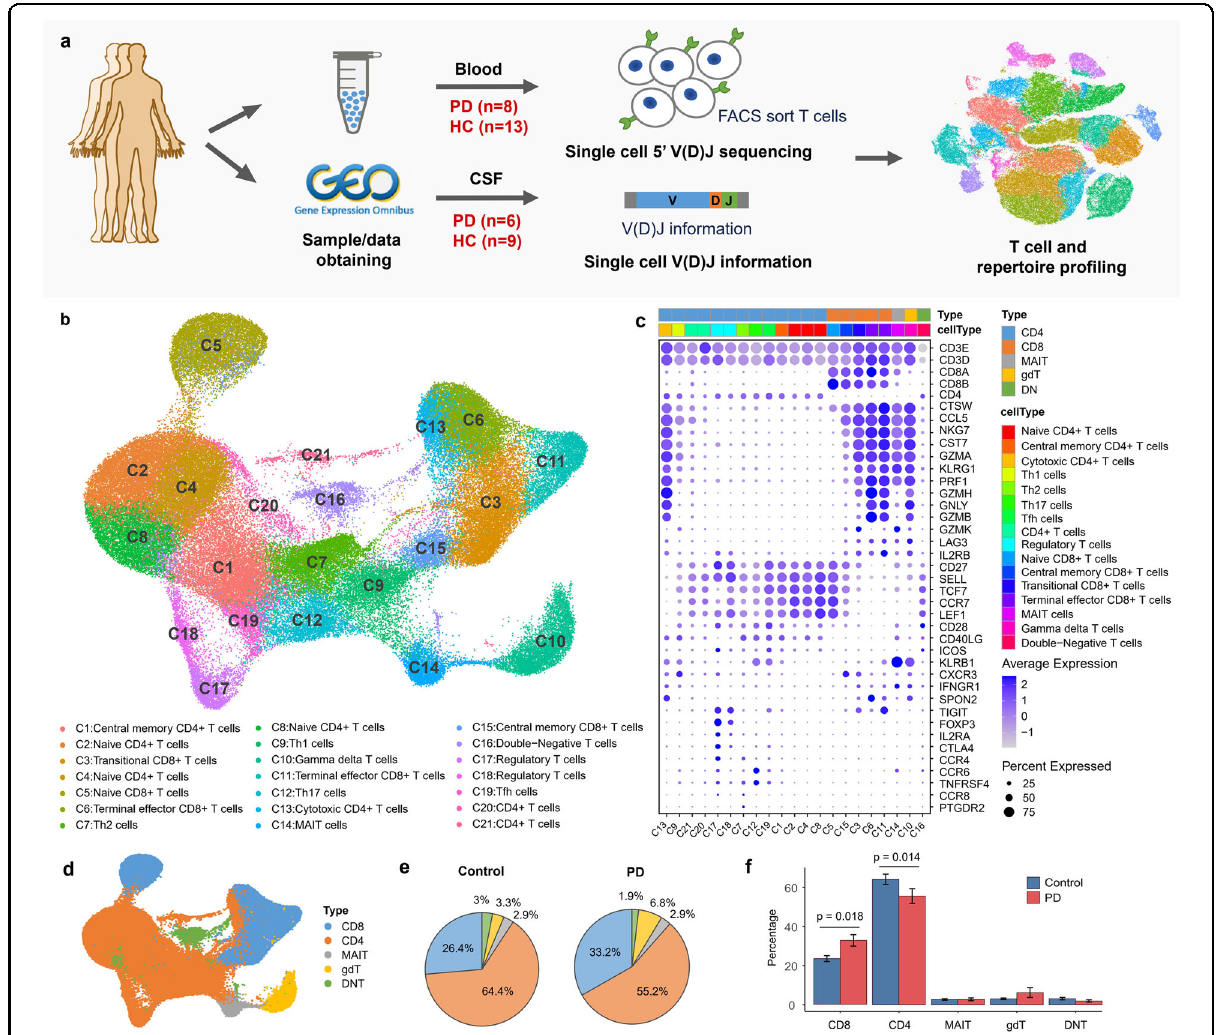
Fig. 1 Single-cell transcriptome pro fi ling of T cells. a Overview of experimental design. CD3 + T cells from the blood of 8 PD patients and 6 healthy controls were sorted by FACS and simultaneously subject to single-cell transcriptome and immune sequencing with 5 ’ V(D)J capture. Single- cell TCR data from cerebrospinal fl uid were downloaded from GEO with accession ID GSE134578. Batch effect correction and unsupervised clustering were performed after merging single-cell datasets. b UMAP projection of 103,365 single T cells, showing 21 clusters. Each dot corresponds to one cell and is colored according to cell cluster. c Dot plot shows the expression of marker genes for 21 cell clusters. The size of the dot corresponds to the percentage of cells expressing the gene in each cluster, and the color represents the average log normalized gene expression. Markers were ordered to visualize the differences between cell types. d UMAP projection of T cells colored by the 5 major T cell types, including CD8 + T cells (CD8), CD4 + T cells (CD4), mucosal-associated invariant T cells (MAIT), gamma delta T cells (gdT) and double-negative T cells (DNT). e Pie charts showing the percentages of the fi ve major T cell types in the blood of PD patients and healthy controls. For each cell type, the percentage was obtained by dividing the number of cells in that cell type by the total number of cells in all PD patients or in all healthy controls. f Barplot showing the percentages for different T cell types identi fi ed from single cell analysis. Error bars represent standard error of the